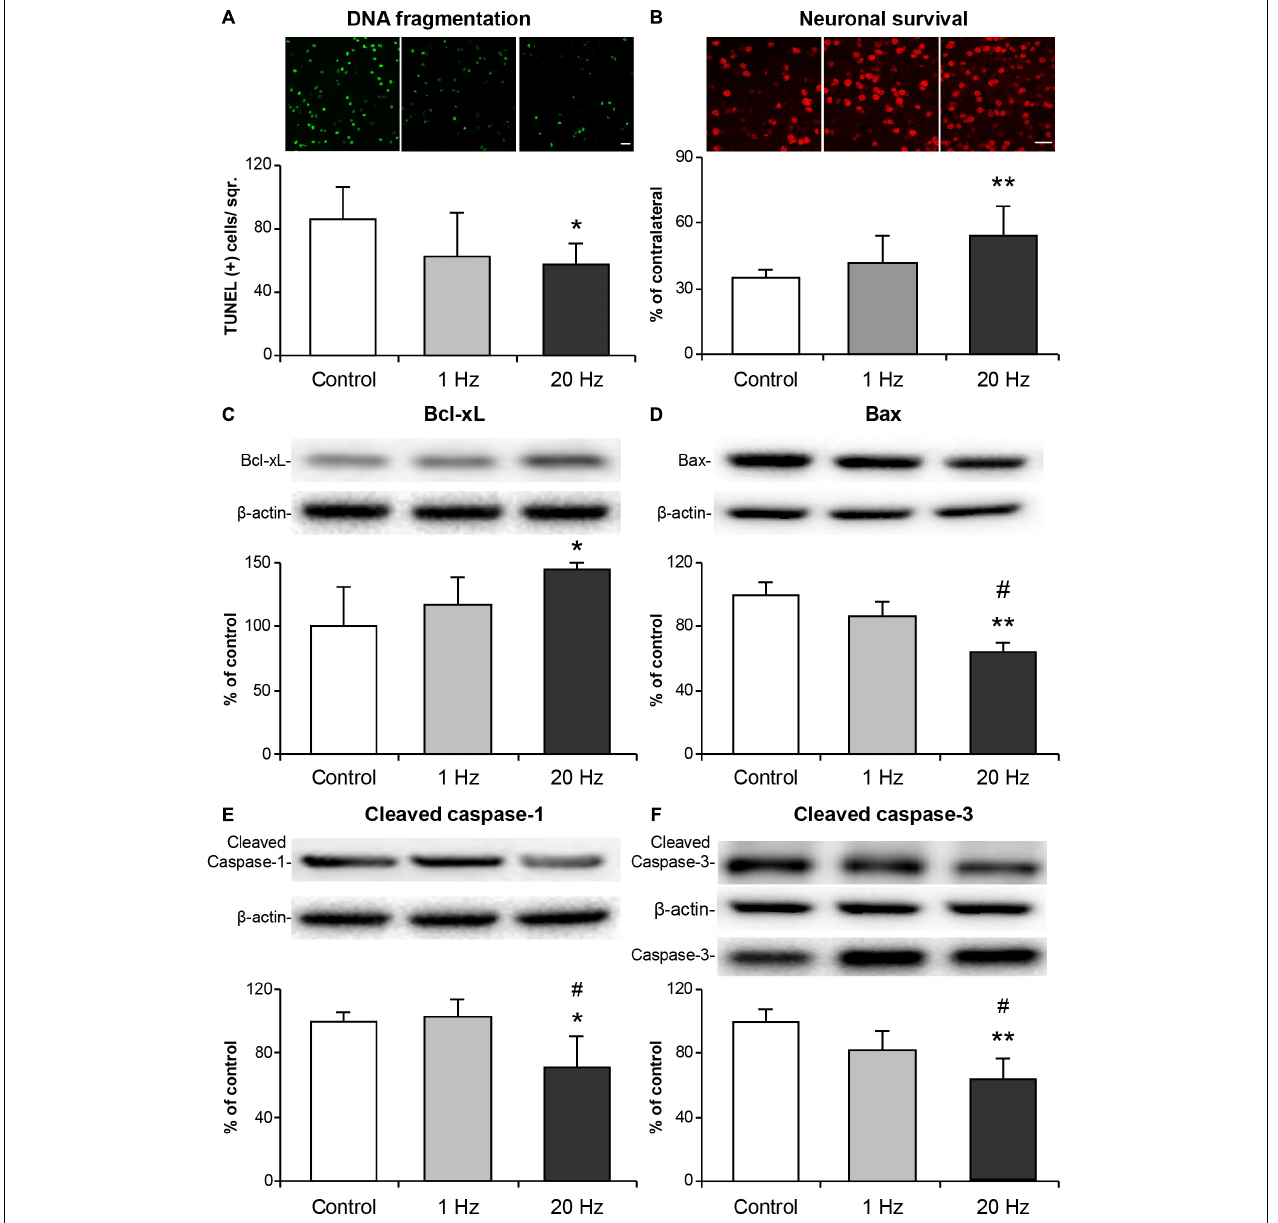
FIGURE 3 | 20 Hz rTMS reduces DNA fragmentation, pro-apoptotic protein expressions and promotes neuronal survival. Disseminate neuronal injury in the striatum was assessed by terminal transferase dUTP nick end labeling (TUNEL) (A) , neuronal survival was assessed using NeuN stained brain sections (B) , expressions of anti-apoptotic Bcl-xL (C) , pro-apoptotic Bax (D) , inflammation related cleaved caspase-1 (E) , pro-apoptotic cleaved caspase-3 (F) were demonstrated with Western blot. Data are mean ± SD values ( n = 6–7 mice/group). Data were evaluated by one-way ANOVA followed by LSD tests. Data are presented as mean ± SD values. ∗∗ p < 0.01/ ∗ p < 0.05 compared with control/ # p < 0.05 compared with 1 Hz rTMS. Scale bars are 100 µ